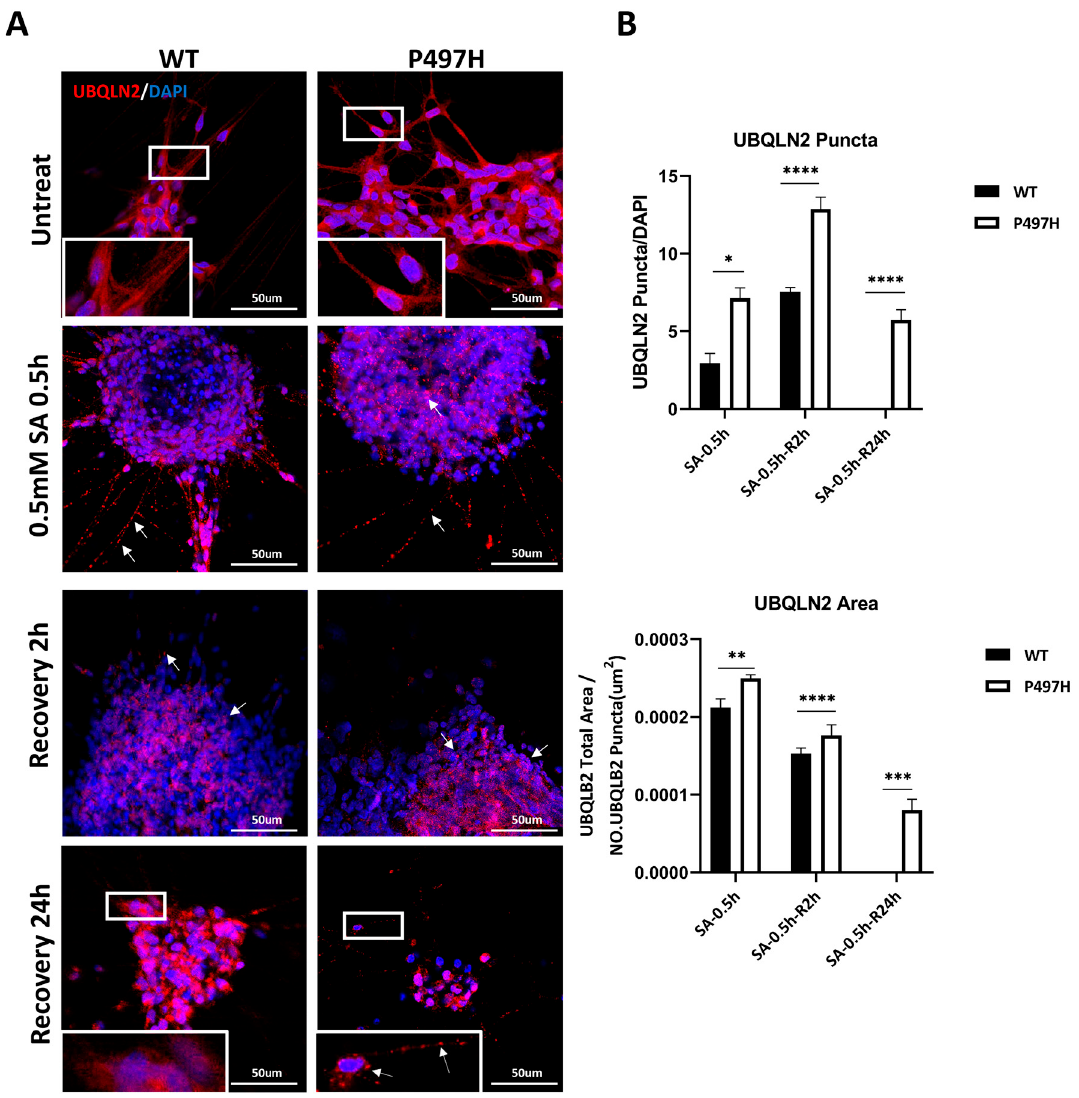
Figure 5. Analysis of UBQLN2 aggregates. ( A ) Representative confocal images of UBQLN2 (red) in WT and mutant MNs at D0, before (untreated), SA treatment (0.5 mM for 0.5 h), and after 2 h and 24 h recovery from SA exposure. White boxes indicate enlarged area in inset, and white arrows indicate UBQLN2 punca. ( B ) Quantitative analysis was carried out using ImageJ software of the number of UBQLN2 puncta or average area of UBQLN2 puncta in WT and mutant MNs, in SA treatment and after 2 h and 24 h recovery from SA exposure. Under SA treatment, UBQLN2 P497H MNs formed more and bigger UBQLN2 aggregates than WT MNs. Data are shown as mean ± SD, n = 3 independent experiments (* p < 0.05, ** p < 0.01, *** p < 0.001, **** p <